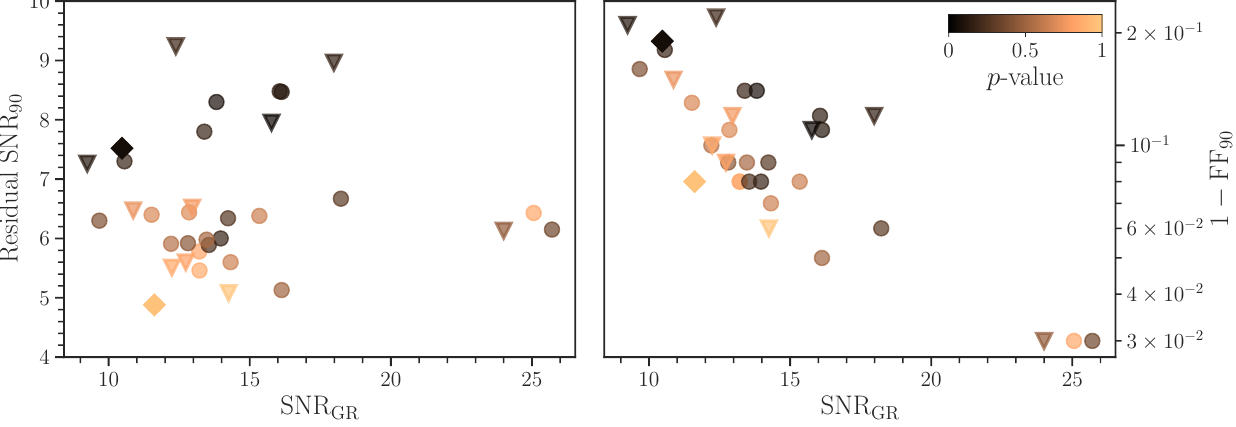
Figure 2. The residual SNR ( left ) and the fitting factor ( right ) as functions of the SNR of the best-fit GR model for BBH observations reported in [30]. The colorbar indicates the p -value associated with each event, with diamond markers noting the maximum and minimum values (see text). O3a events are distinguished from the O1/O2 events by circle and triangle-shaped markers,